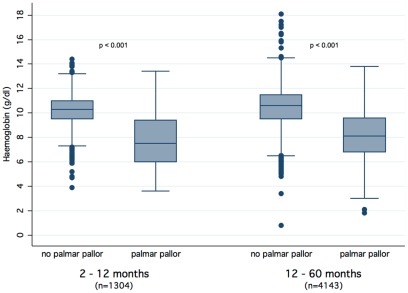
Distribution of haemoglobin-values in patients of different ages with and without palmar pallor.p-value was calculated assuming a Student's t distribution.